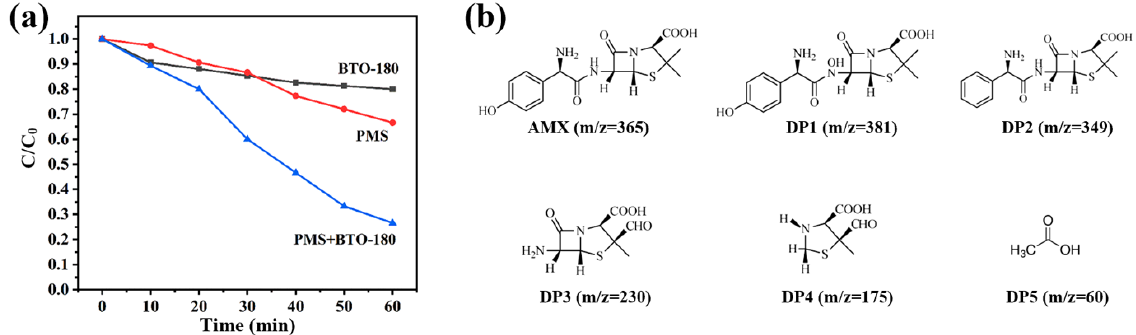
Figure 7. ( a ) The degradation of AMX by PMS, BTO-180, and PMS/BTO-180. ( b ) The detected DPs during the reaction.